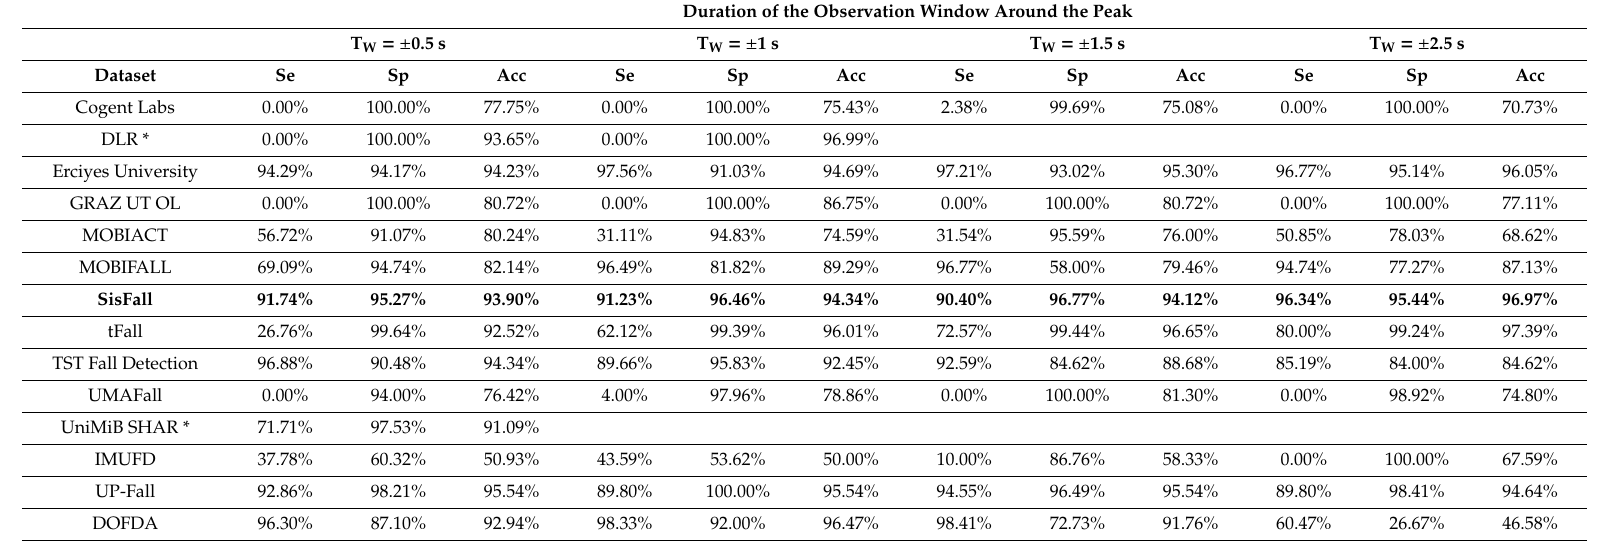
Table 7. Comparison of the obtained performance metrics for the 14 datasets and the four di ff erent observation windows ( T W ) around the peak when the acceleration magnitude (SMV) was used to feed the convolutional neural network (the results for the reference dataset -SisFall- are marked in bold). Note: * Some observation windows could not be applied to these datasets due to the short duration of the